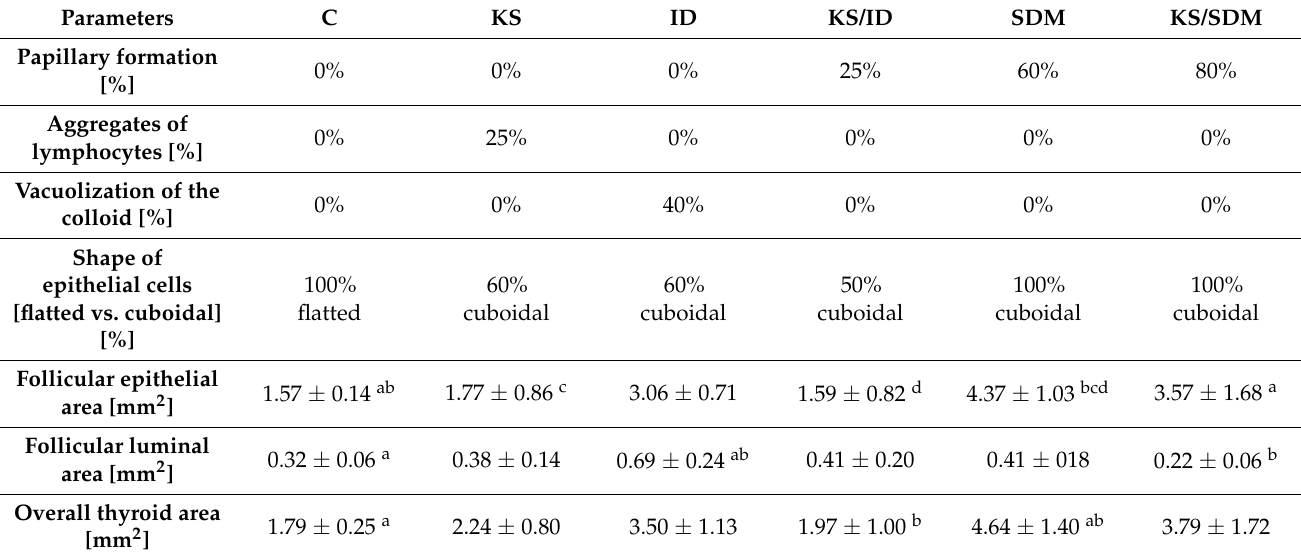
Table 3. Qualitative and quantitative parameters describing the changes observed during histopathology of thyroid glands of the investigated rats (see Section 2.2. for the explanation of the groups’